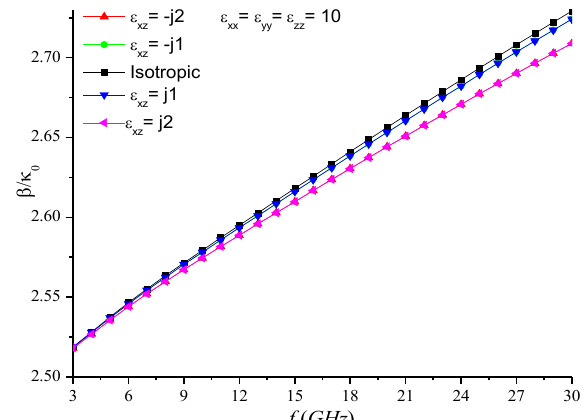
Figure 10.a: Effect of imaginary valued e xz the normalized phase constant